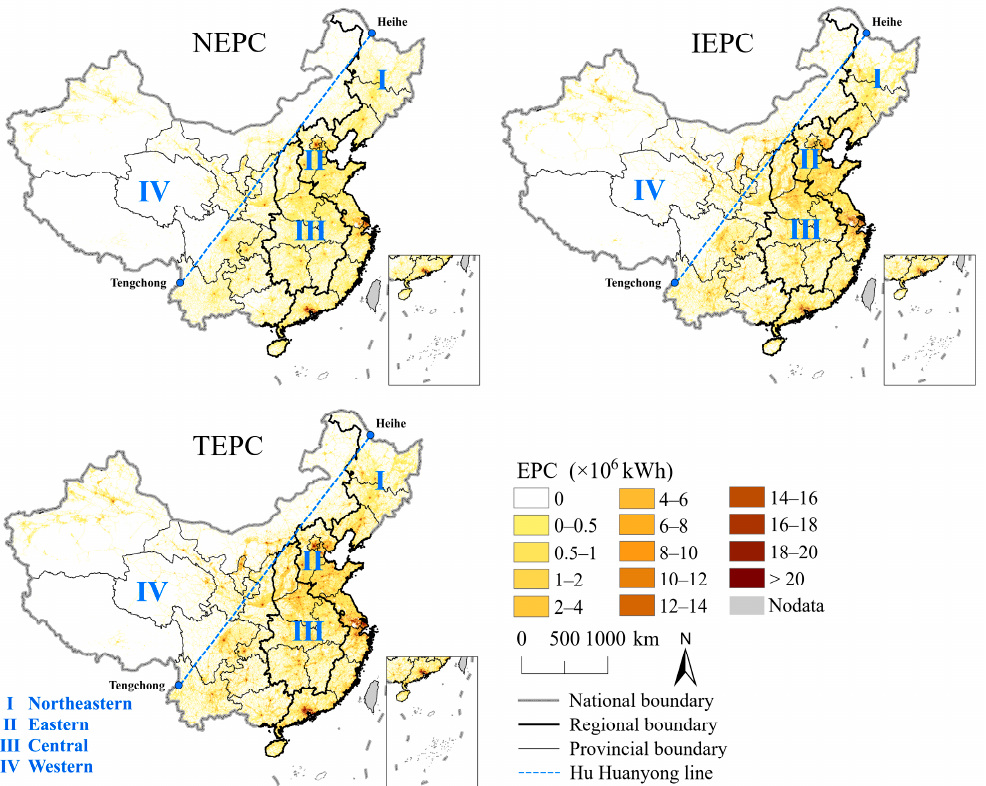
Figure 4. Estimated electric power consumption maps in mainland China in 2011.